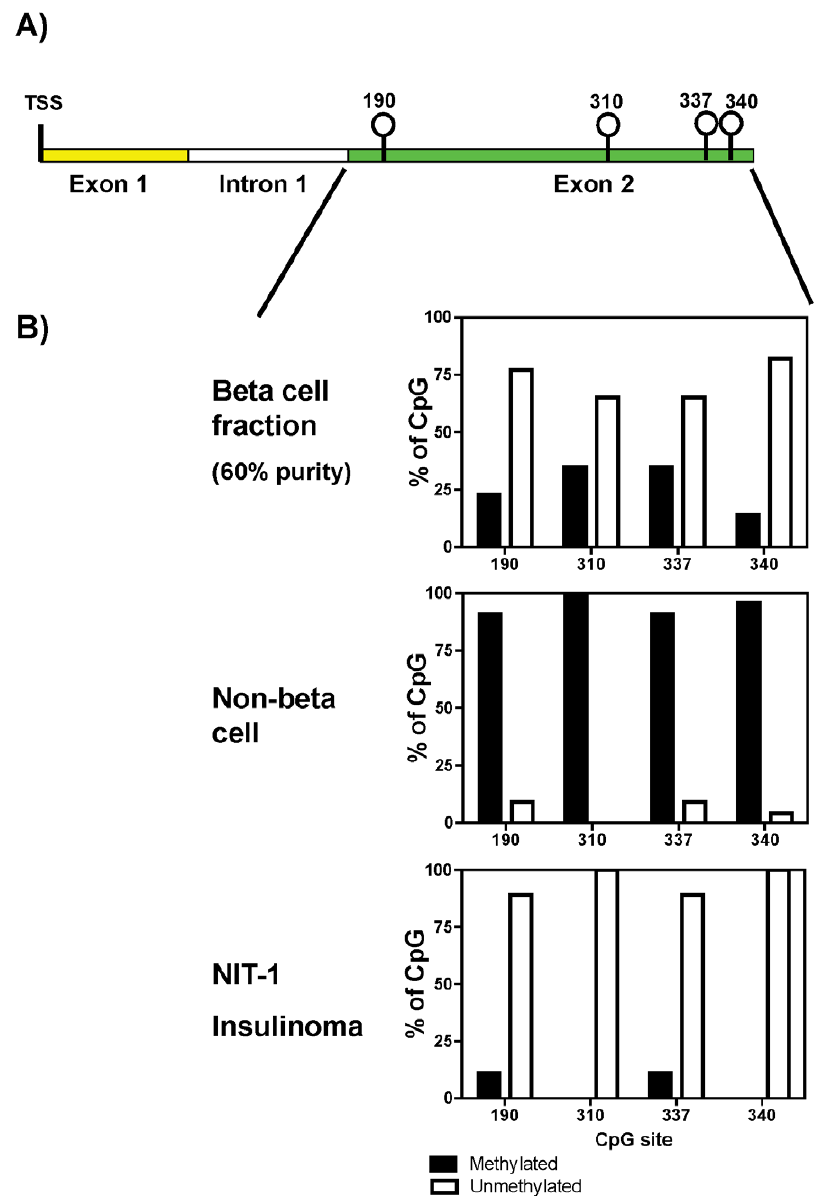
Figure 1. Beta cell-specific demethylation of exon 2 of the mouse Ins2 gene. A) Schematic illustration of the mouse Ins2 gene with exon 1 (yellow), intron 1 (white), and exon 2 (green) with the positions of the CpG sites indicated. B) Methylation pattern of mouse Ins2 exon 2 showing the percentage of methylated (solid box) and unmethylated (empty box) CpG sites obtained from the 60% mouse beta cell fraction [21], NIT-1 mouse insulinoma cell line, and other mouse tissues (liver, spleen, kidney, brain, muscle, and blood). Each pattern results from 17, 9, and 23 clones of pancreatic beta cell fraction, NIT-1, and other tissues, respectively. TSS indicates the transcription start site.